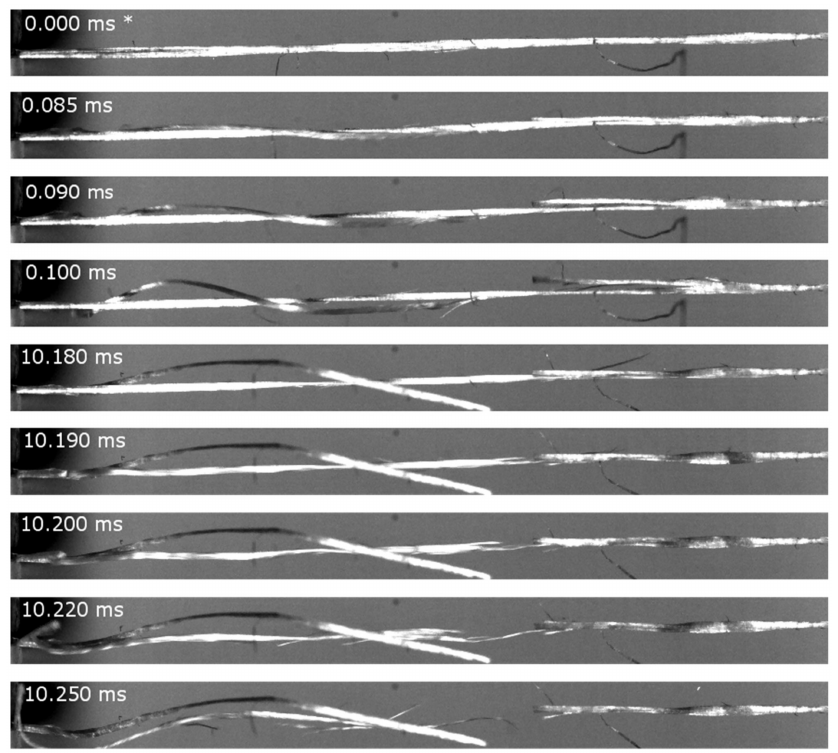
Figure 7. Ultra-high-speed camera observation during tensile tests of sisal fibre bundles. *: 0 ms presents the last picture without any visible fibre failure.